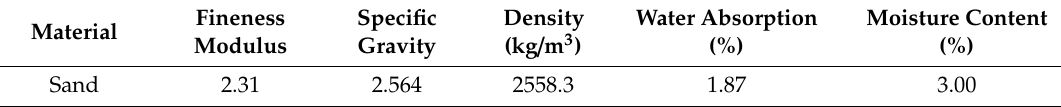
Table 2. Fine aggregate